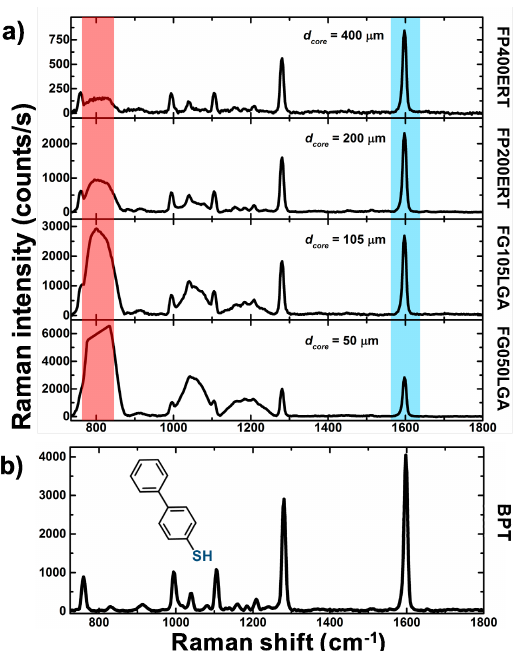
Figure 7. ( a ) Raman spectrum from 100 mM Biphenyl-4-thiol (BPT) solution through different optical fibers ( b ) Raman spectrum from the BPT solution with the Raman microscope without the fibers.